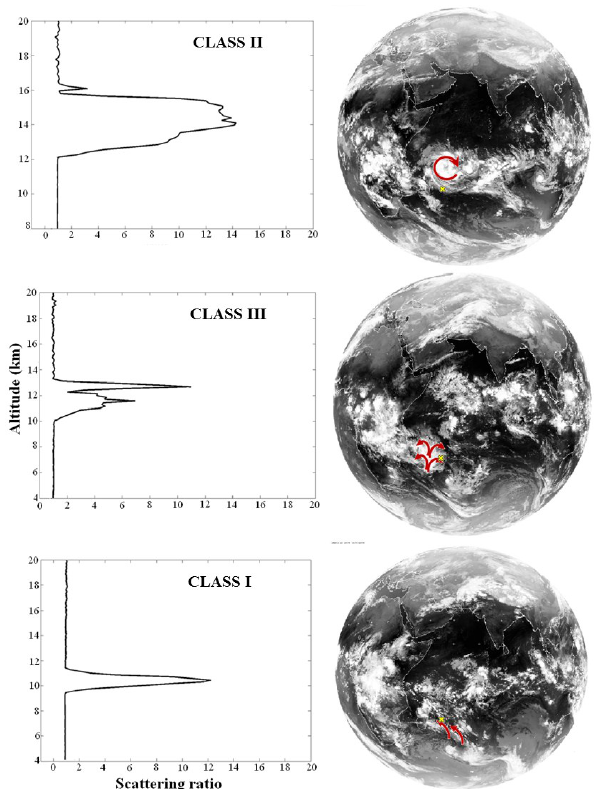
Figure 12. Representation of different cirrus cloud classes. Left panels represent the scattering 2 Fig. 12. Representation of different cirrus cloud classes. Left panels ratio profiles for each class and right panels represent the corresponding MeteoSat image. 3 represent the scattering ratio profiles for each class and right panels Reunion Island is indicated by yellow cross. Atmospheric move is represented by red arrows. 4 represent the corresponding MeteoSat image. Reunion Island is in- The corresponding dates are 16 th March 2005, 15 th December 2004 and 9 th February 2003 5 dicated by a yellow cross. Atmospheric move is represented by red (from the top to the bottom). 6 arrows. The corresponding dates are 16 March 2005, 15 Decem- ber 2004 and 9 February 2003 (from the top to the